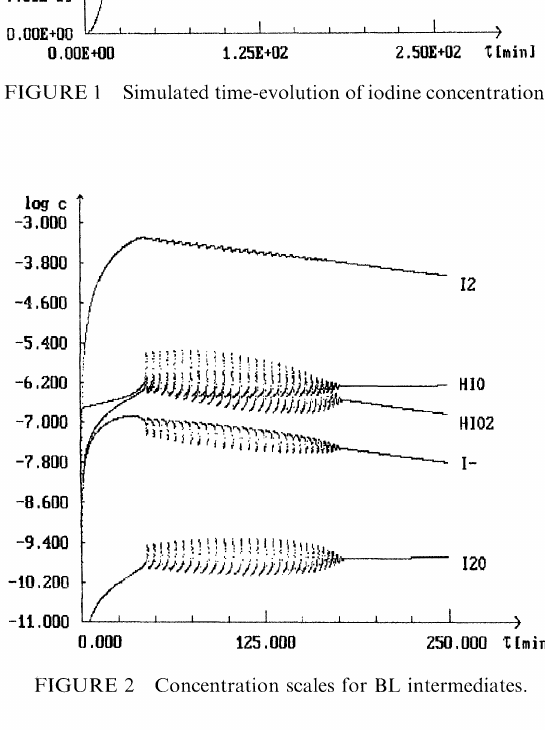
FIGURE 2 Concentration scales for BL